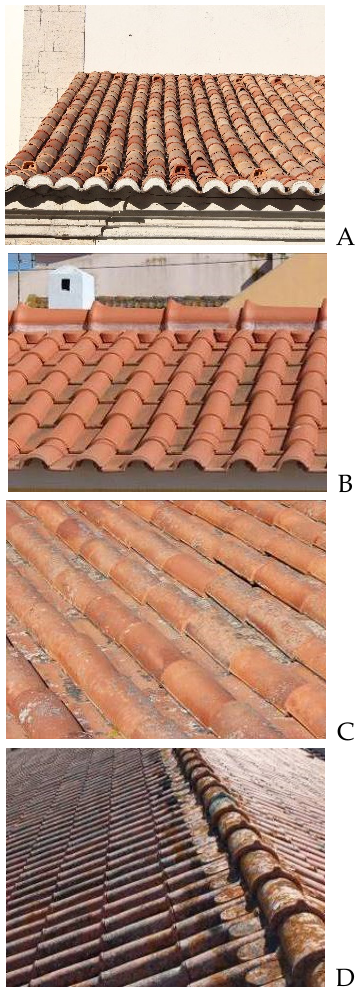
Figure 1. Illustrative examples of the degradation condition of the pitched roofs analysed. From top to bottom: Condition A — S w ≤ 1%; Condition B —1% < S w ≤ 6%; Condition C —6% < S w ≤ 20%; Condition D —20% < S w ≤ 50%; and none of the elements analysed are in condition E.